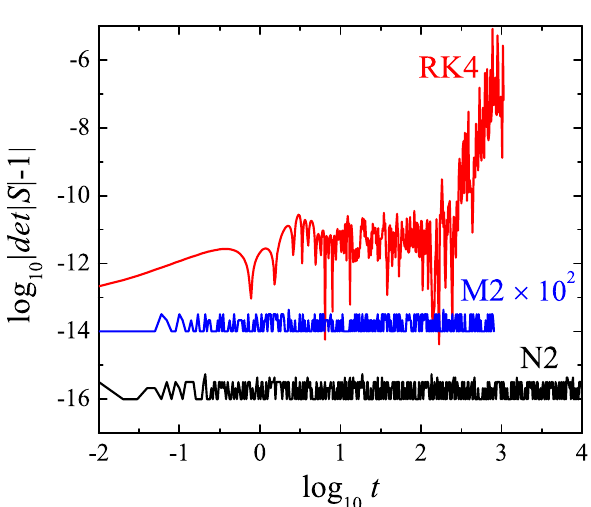
Figure 2. Difference between 1 and the determinant det | S | of the matrix S for each of the three methods RK4, M2 and N2. The time step is τ = 0.01 and energy is E = 1/120. The initial conditions are x = 0, y = − 0.988 and p y = 0. M2 × 100 means that the plotted values are 100 times larger than the practical values.